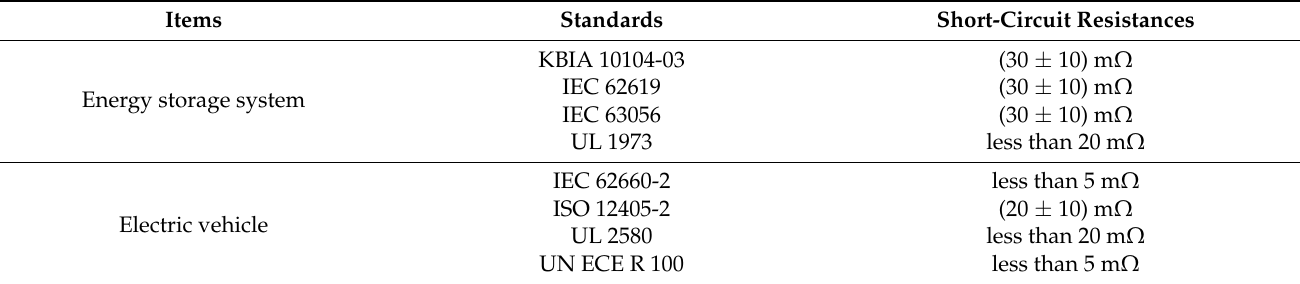
Table 1. Short-circuit resistances in Li-ion battery standards [18–32].